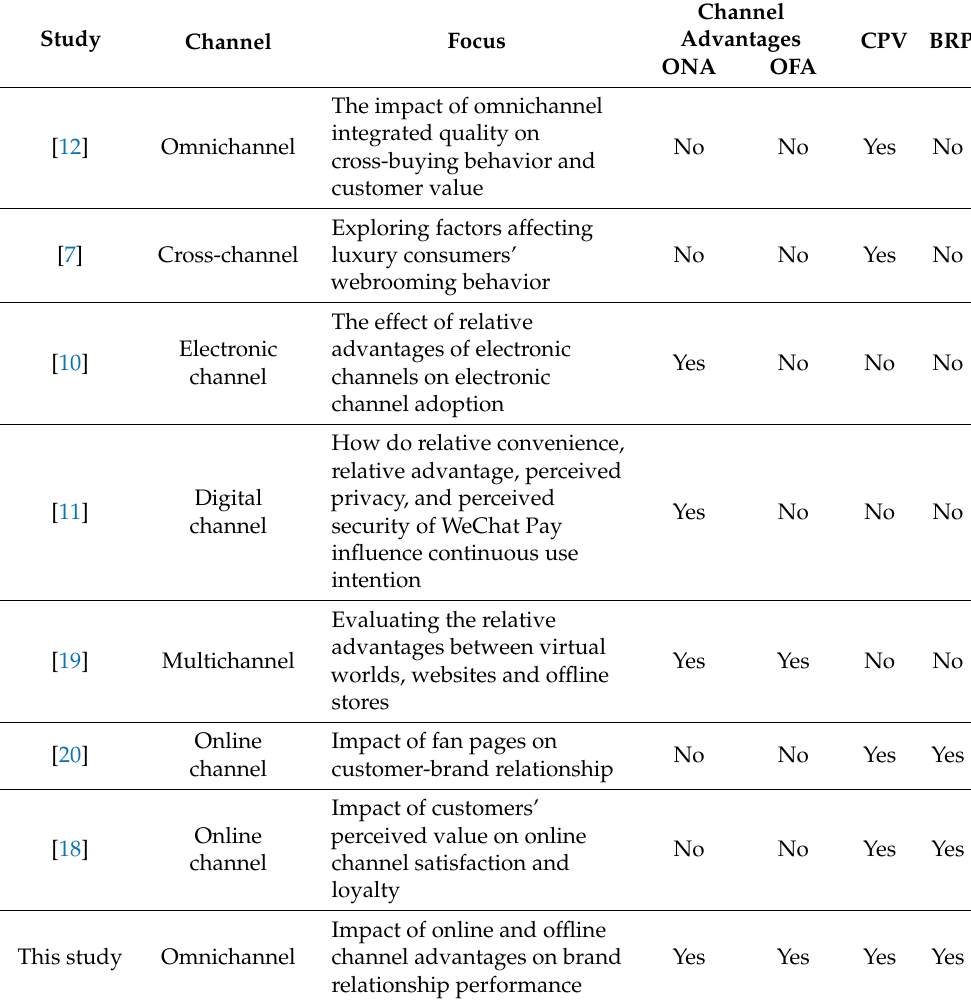
Table 1. Key relevant literature on channel advantages, CPV, and BRP.